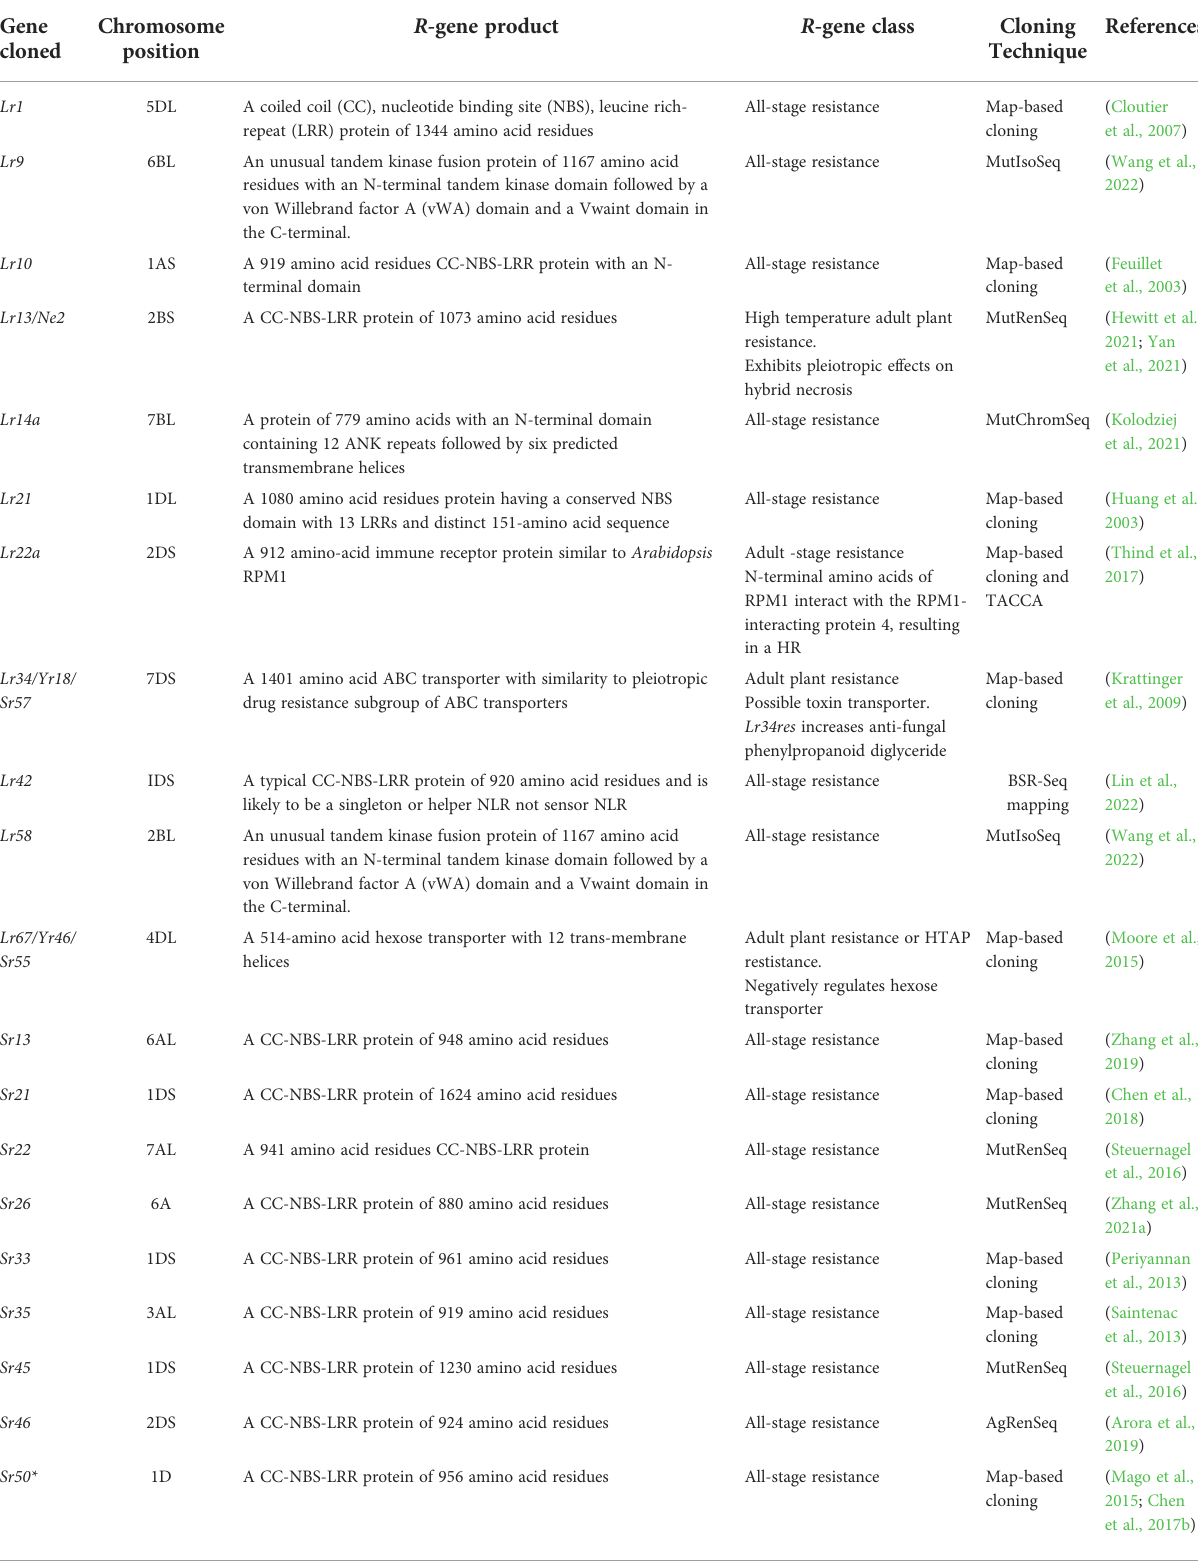
TABLE 1 A summary of cloned Lr, Sr , and Yr genes for leaf rust, stem rust, and stripe rust resistance,